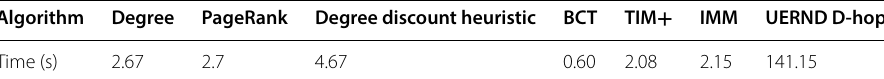
50 under the LT model =